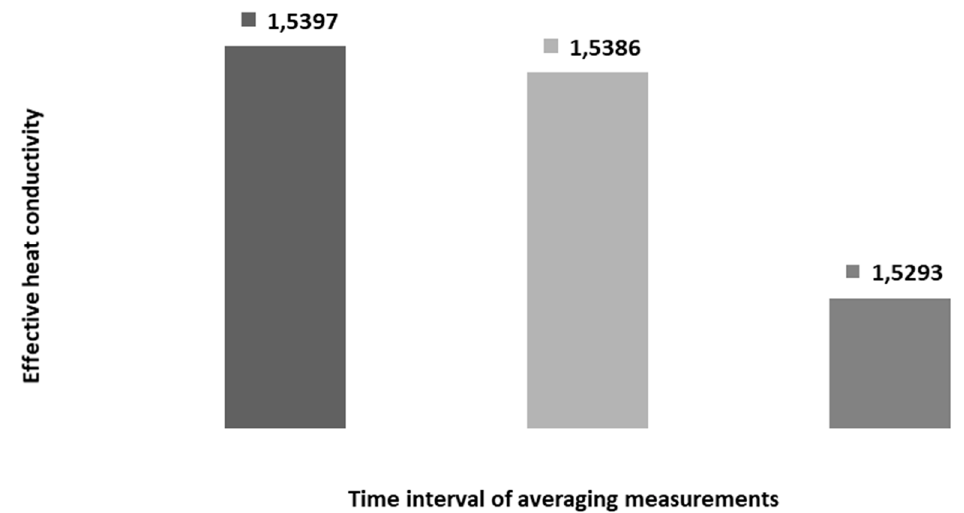
Figure 13. Effective thermal conductivity λ eff depending on time interval for BHE-3 (single U-pipe).